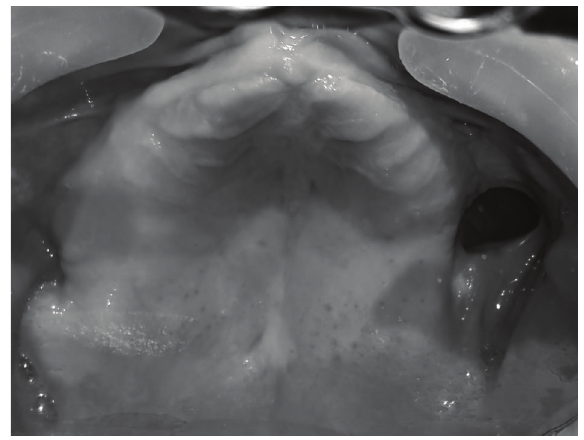
Figure 5: Intraoral photograph showing oronasal fistula in maxilla.